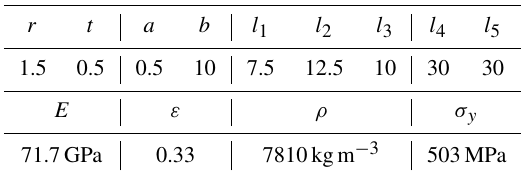
Table 1. Geometric parameters (mm) and properties of material of the